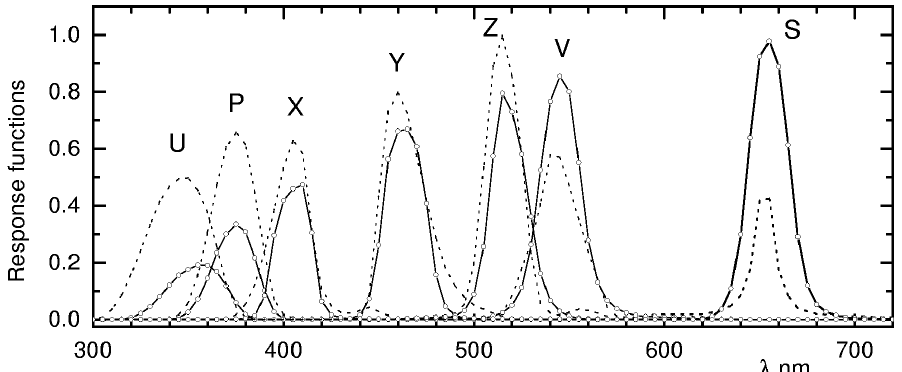
Fig. 3. Response functions of the instrumental CCD system (solid line) and the standard Vilnius system (dotted line). The standard func- tions are from Straiˇzys